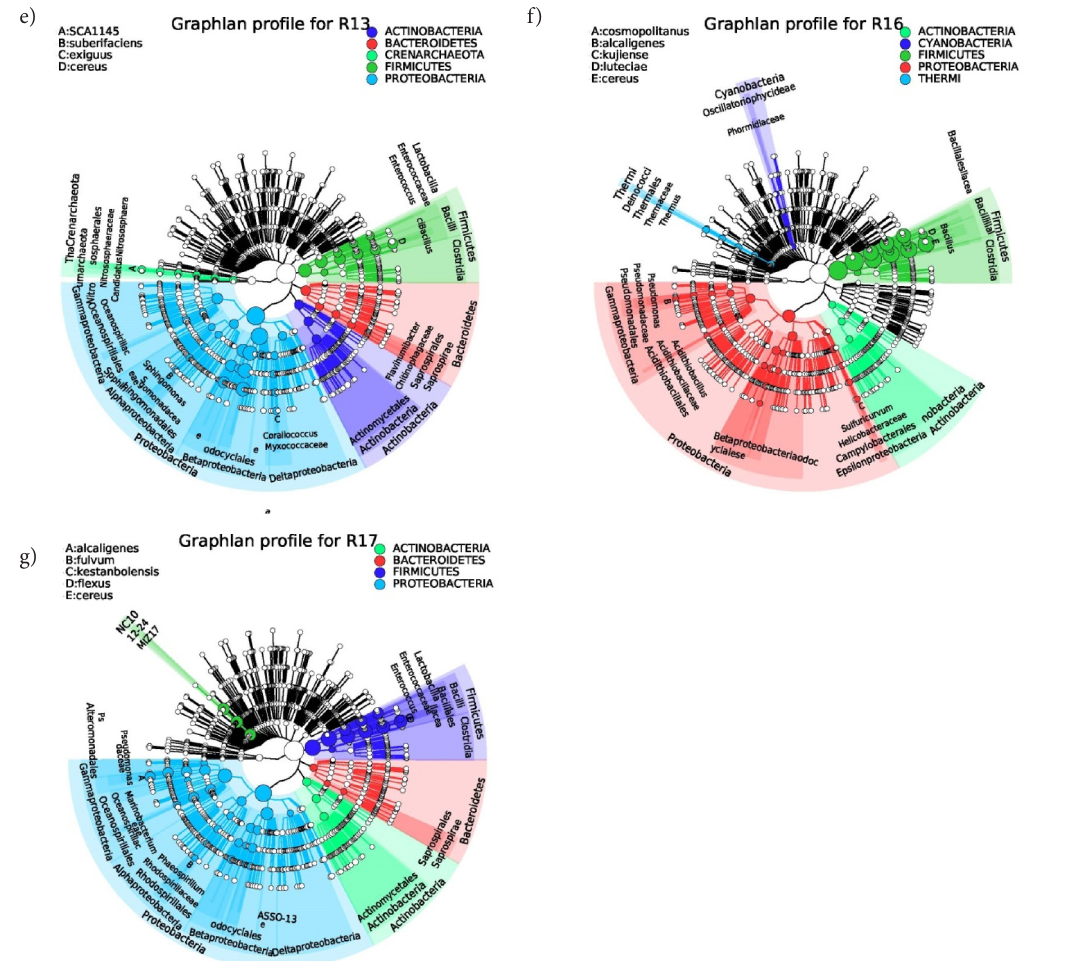
Figure 4. Phylogenetic relationship analysis of various organisms that are associated in the mining area with the organism obtained by 16Sr